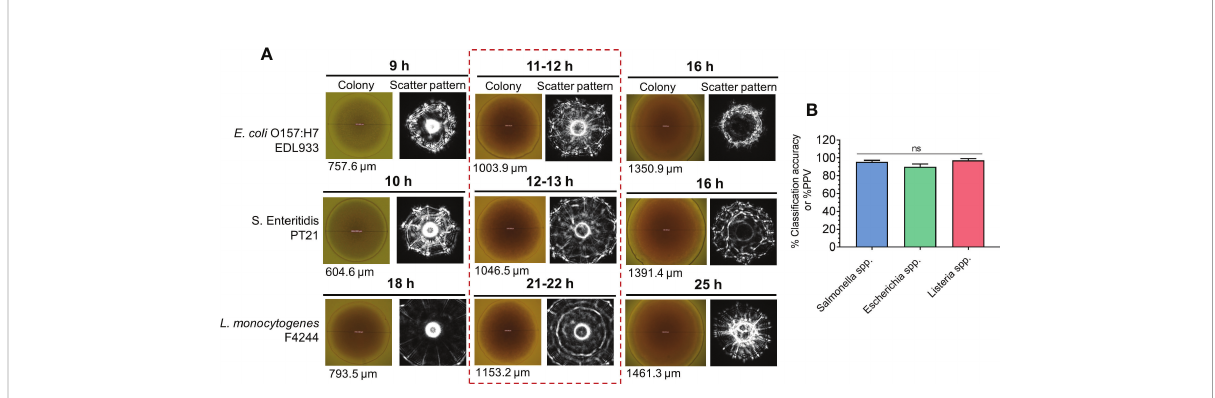
FIGURE 6 Simultaneous detection and identi fi cation of colonies of E . coli O157:H7, Salmonella enterica , and Listeria monocytogenes on multi-pathogen selective media, SEL ( Salmonella , Escherichia , Listeria ) using BARDOT. (A) colony scatter signature of colonies after 9-25 h of growth. (B) Classi fi cation accuracy of all three test pathogens ( E. coli , Salmonella and Listeria ) after 11-22 h from (A) Souce (Abdelhaseib et al., 2019). ns, not signi fi cant at